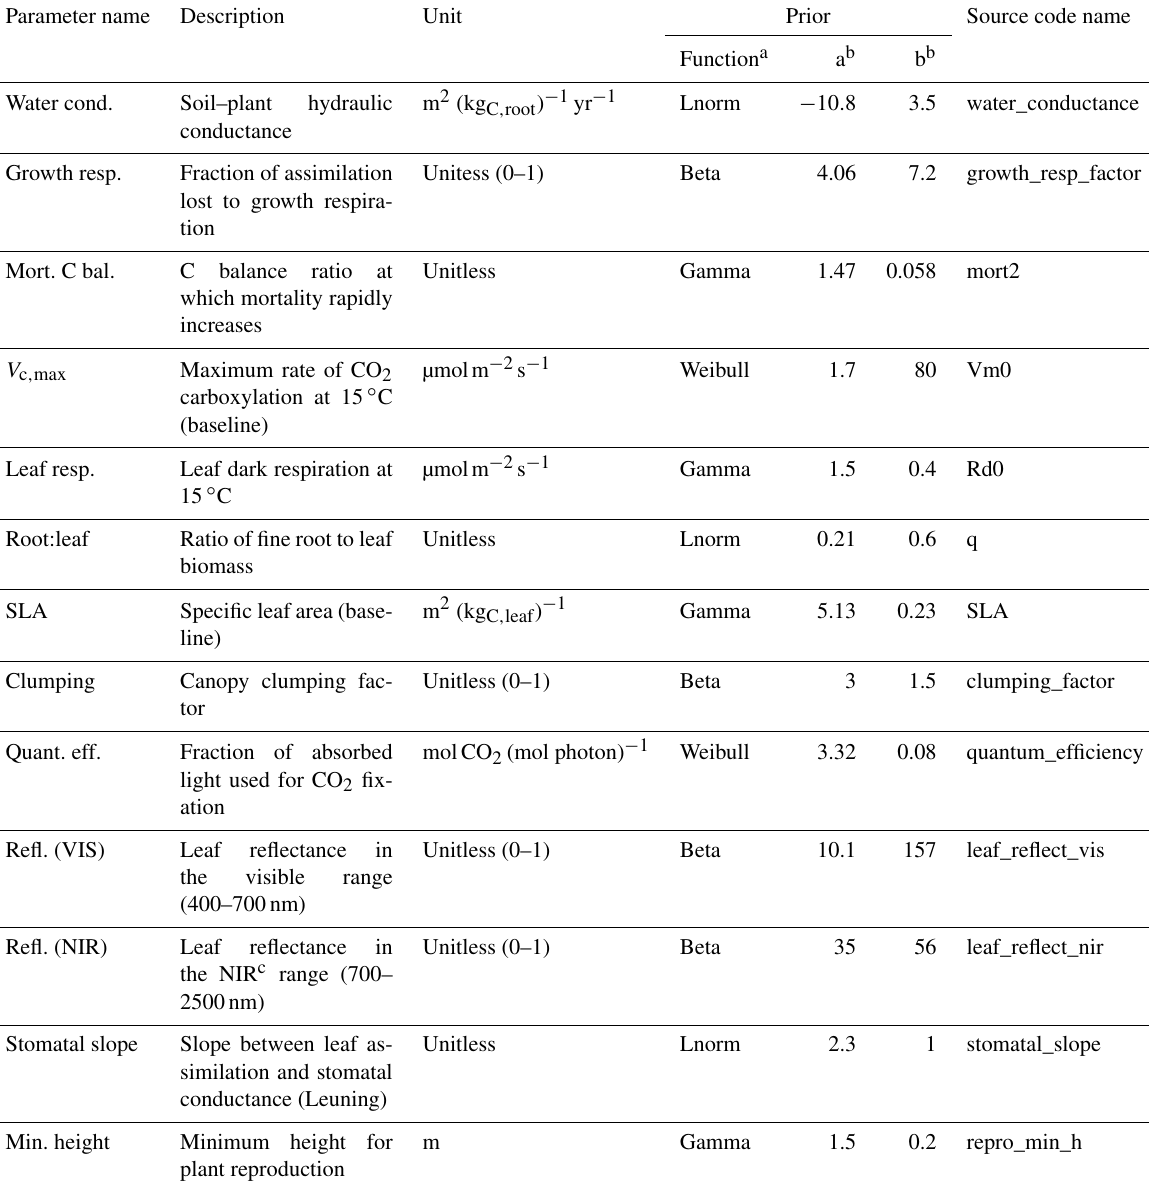
Table 4. Description of the ED2.2 parameters varied in this study, their units, and the definitions of their priors, which were used to evaluate the model parameter uncertainty. “Source code name” is the name of the parameter as it appears in the ED2.2 source code. When trait plasticity is enabled, both SLA and V c , max may change over time and for different cohorts of the same